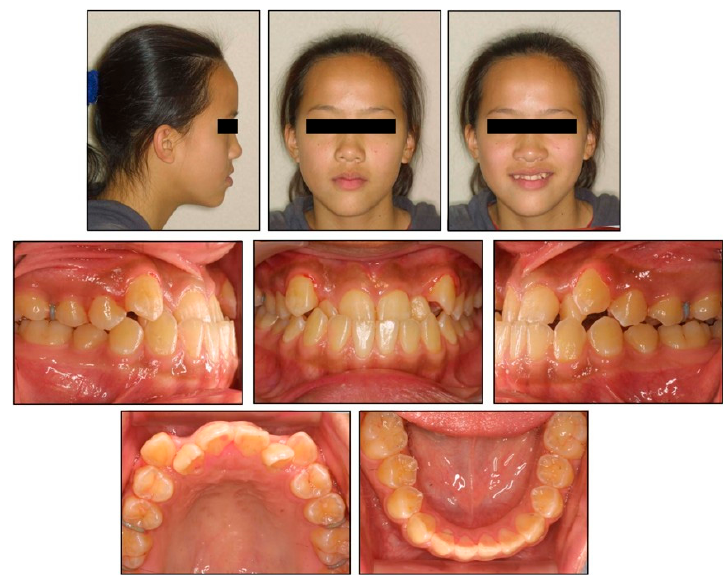
Figure 1. Case 1, Pretreatment facial and intraoral photographs.